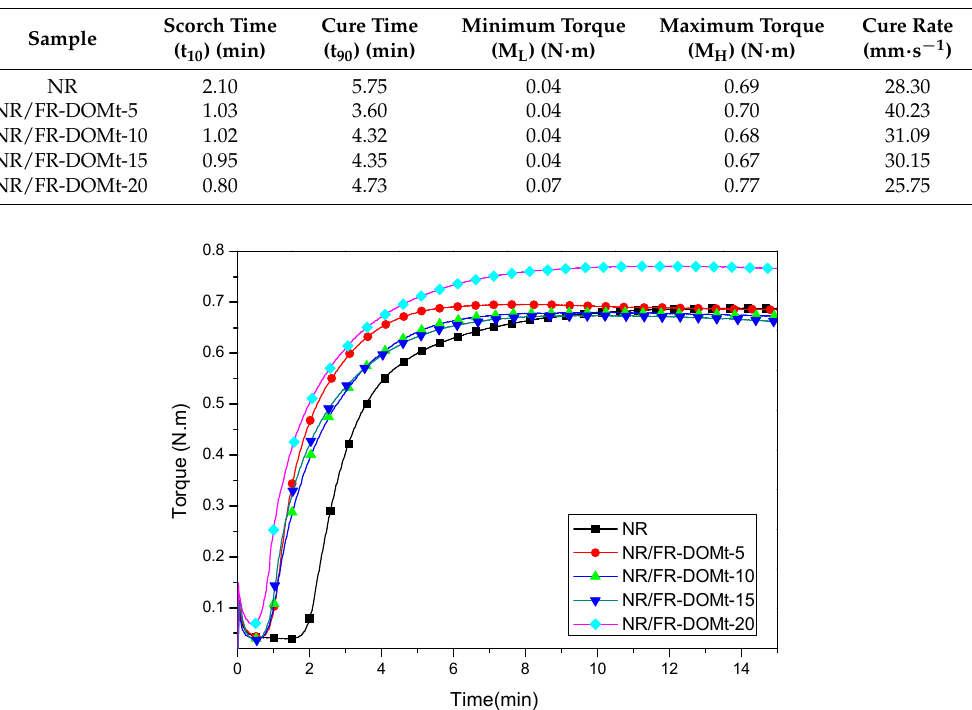
Table 2. Cure characteristics of FR-DOMt filled NR nanocomposites at 150 °C.